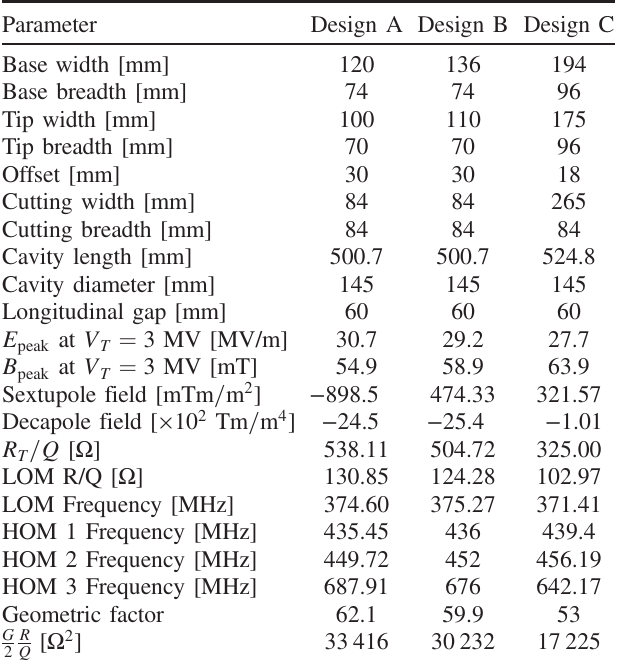
TABLE I. A table of parameters for the final crab cavity designs.